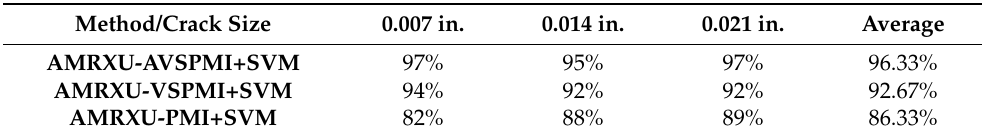
Table 12. The average accuracy for outer crack size detection from the proposed